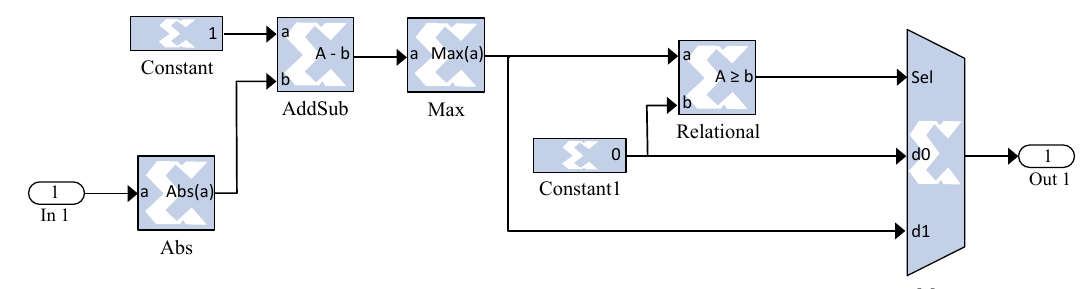
Figure 8. Implemented NN using a Xilinx system generator.